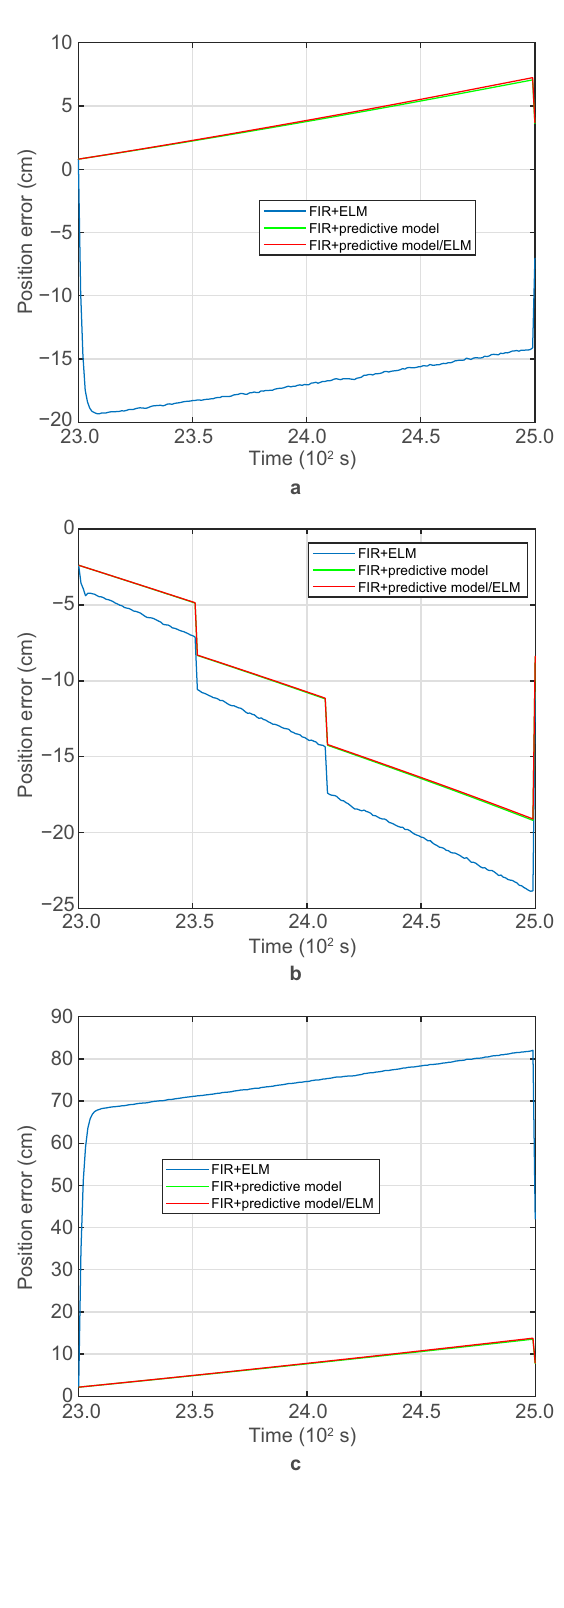
Fig. 9 The localization errors measured by the FIR FIR predictive mode, and the FIR + data missing region: a east direction, b north direction, c up direction